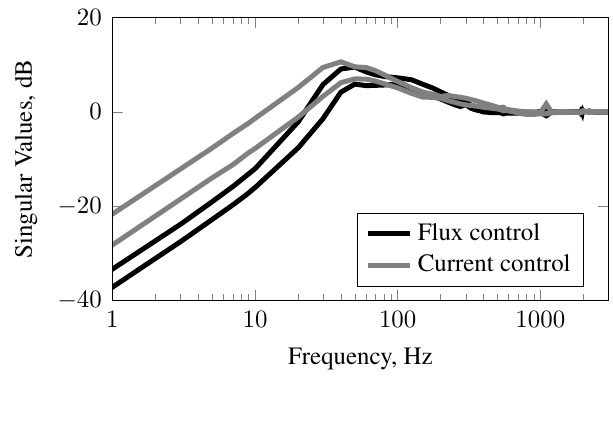
Figure 8. Measured maximum singular values for output sensitivity functions at 11 , 000